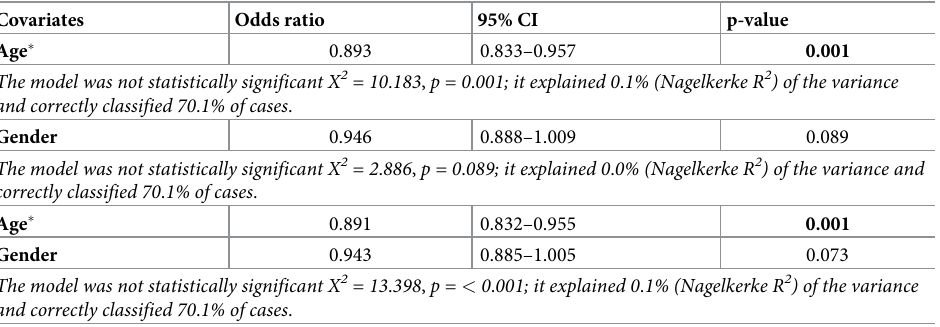
Table 2. Binary logistic regression analysis of independent predictors of positive anti-SARS CoV-2 Ig levels. Covariates Odds ratio 95% CI p-value Age � 0.893